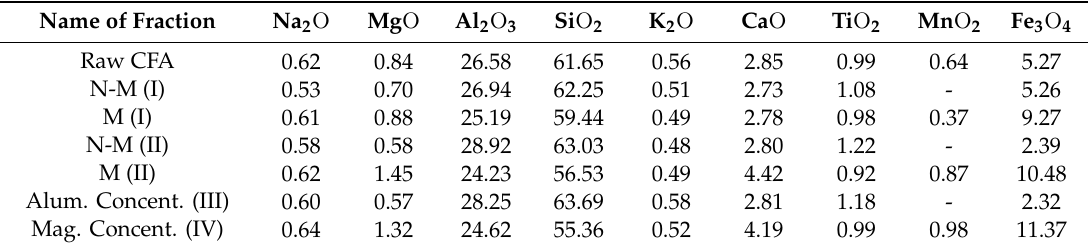
Table 2. Chemical composition (wt %) of the fraction after dry magnetic separation of the raw CFA *. Name of Fraction Na 2 О Mg О